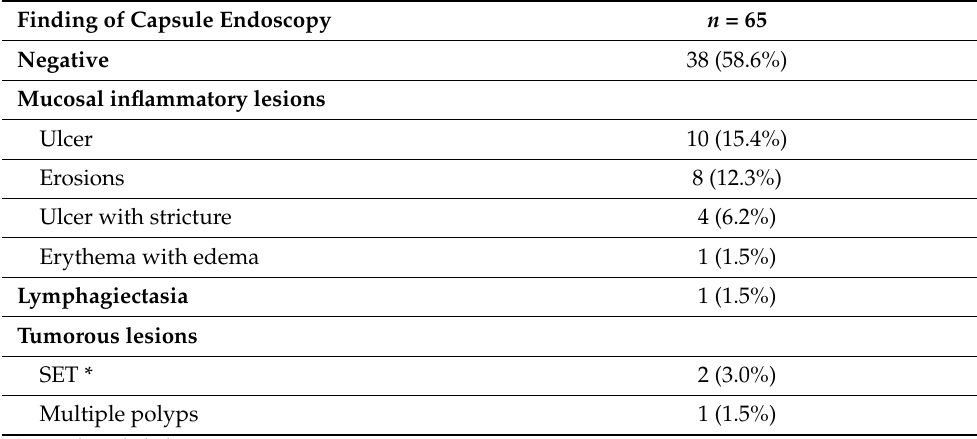
Table 2. Findings of video capsule endoscopy.